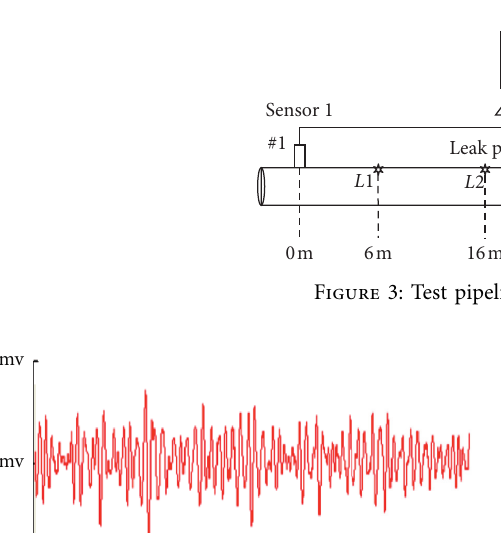
Figure 2: Acoustic emission detection system layout: (a) sensor arrangement, (b) leakage hole diagram, and (c) arrangement of field detection sensors.